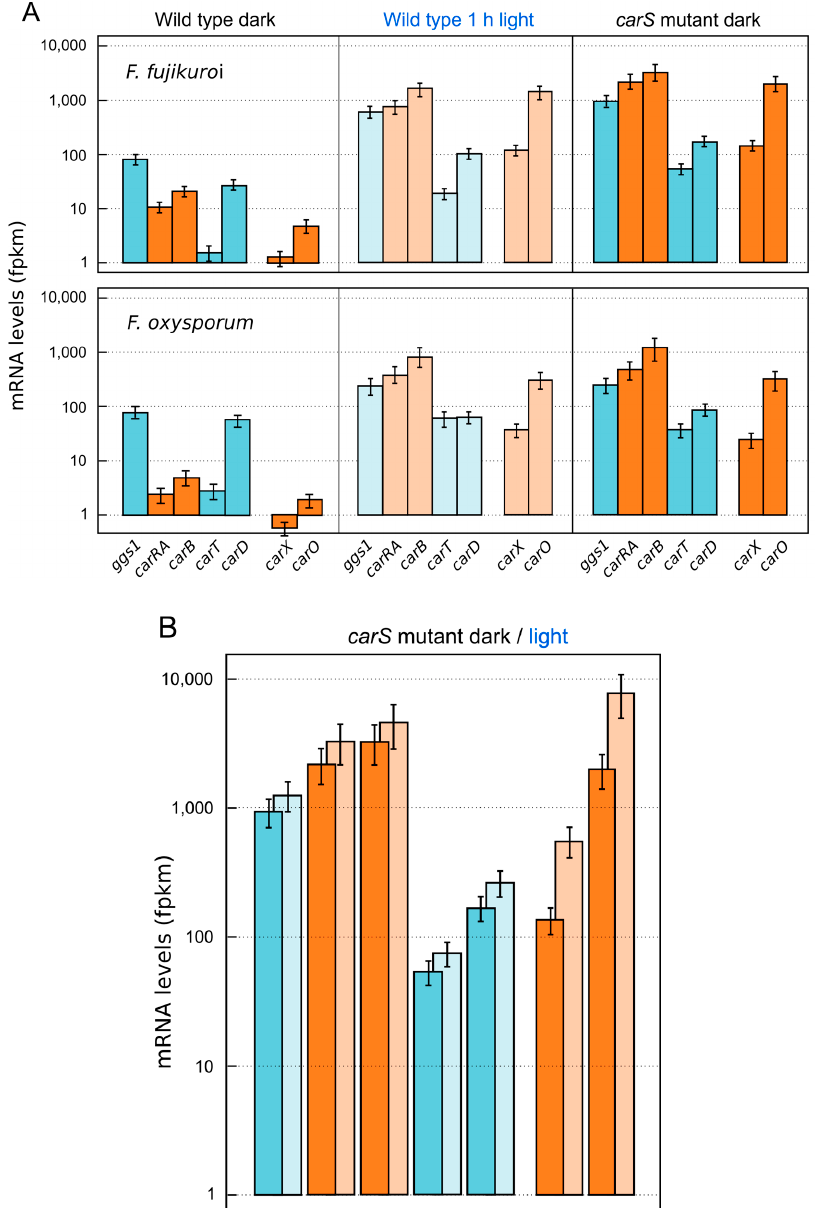
Figure 3. Effect of light and carS mutation on the expression levels for the Fusarium genes involved in carotenoid metabolism. The genes are grouped according to their functions: ggs1 , carRA , carB , carT, and carD involved in NX biosynthesis and carX and carO involved in retinal and CarO rhodopsin production. Orange colors correspond to the genes organized as a cluster, and blue color to genes unlinked in the genome. Darker colors indicate cultures incubated in the dark and paler colors indicate cultures illuminated for one hour. ( A ) Above: wild-type strain IMI58289 of F. fujikuroi and its carS mutant SG39. Below: wild type strain 4287 of F. oxysporum (f. sp. lycopersici ) and its carS mutant SX2; ( B ) Effect of light on the mRNA levels of the carS mutant SG39. RNA-seq data and culture conditions correspond to analyses already described [71]. In brief, all strains were cultured for three days in dark in minimal medium (DG medium for F. fujikuroi and DG with 3 g asparagine instead of NaNO 3 for F. oxysporum ). In the cases indicated, the cultures were exposed to one hour of illumination. RNA samples were sequenced with Illumina technology and the resulting data were analyzed with software tools for read mapping (Bowtie and TopHat), transcriptome assembly (Cuffmerge and Cufflinks), and differential gene expression analysis (Cuffdiff and